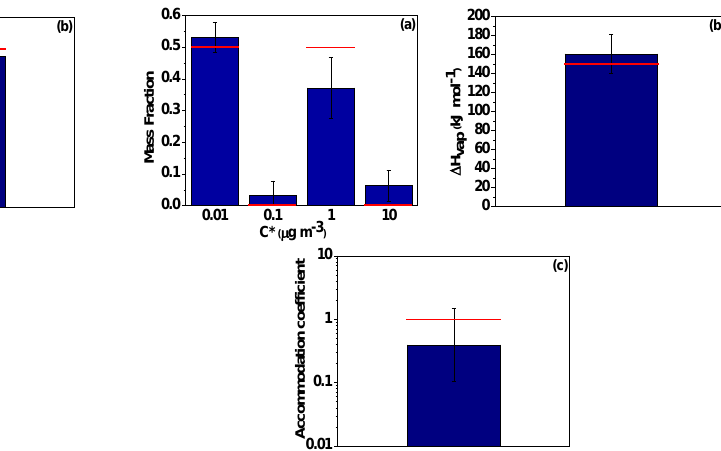
Figure 8. Estimated (bars) and true (red lines) parameter values combining TD and isothermal dilution measurements, for an OA with 60% 0.01 μg m -3 and 40% 10 μg m -3 , ΔH vap =100 kJ mol -1 and a m =1 for: (a) volatility distribution, (b) ΔΗ vap , (c) a m .